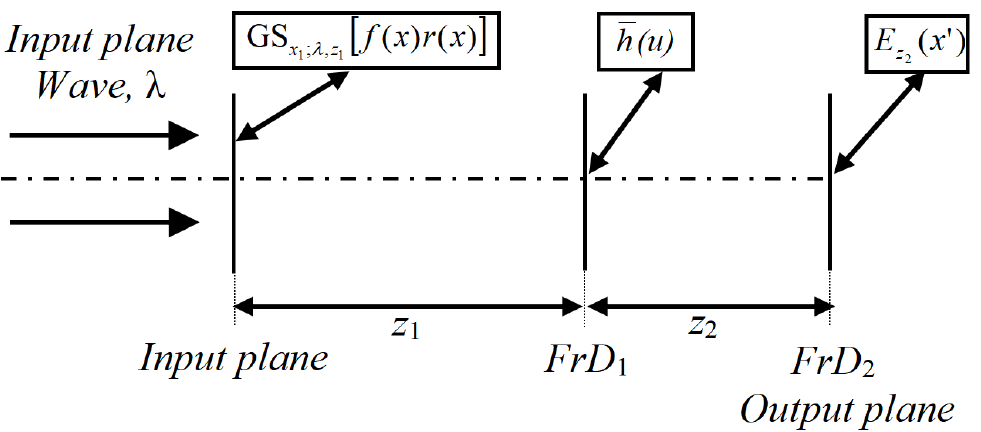
Figure 1. Optical schematic diagram of the proposed encryption system, where the data distribution in the first FrD is ¯ h ( u ) = exp {− i 2 π x 2 u / λ z 1 } h z